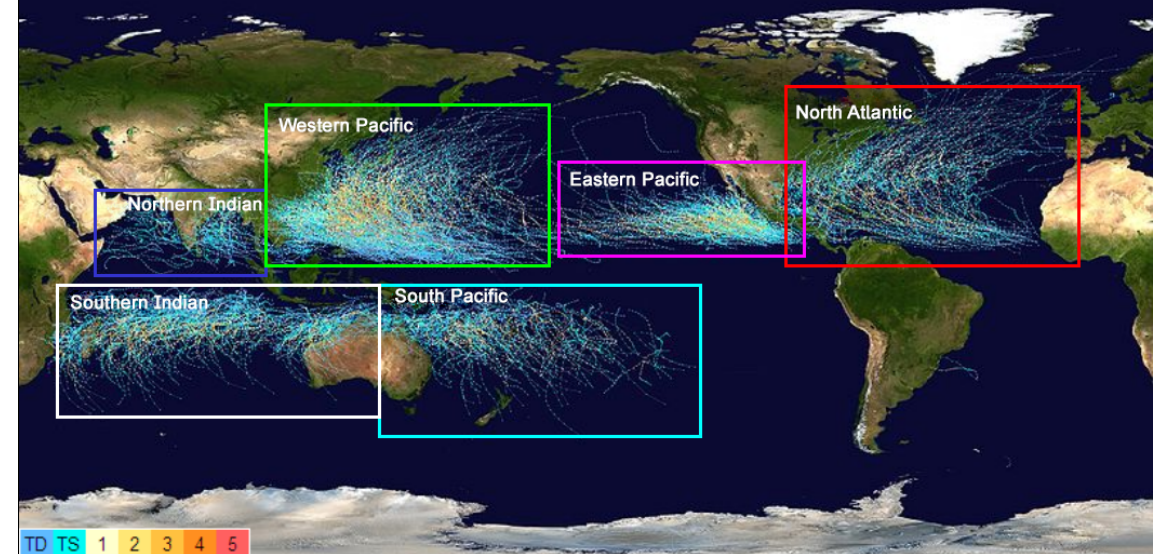
Figure 2. Illustration of TC tracks (background from Wikipedia) for ocean basins: North Atlantic Ocean (red), eastern Pacific Ocean (ma- genta), western Pacific Ocean (green), South Pacific Ocean (cyan), northern Indian Ocean basin (blue) and southern Indian Ocean basin (white).